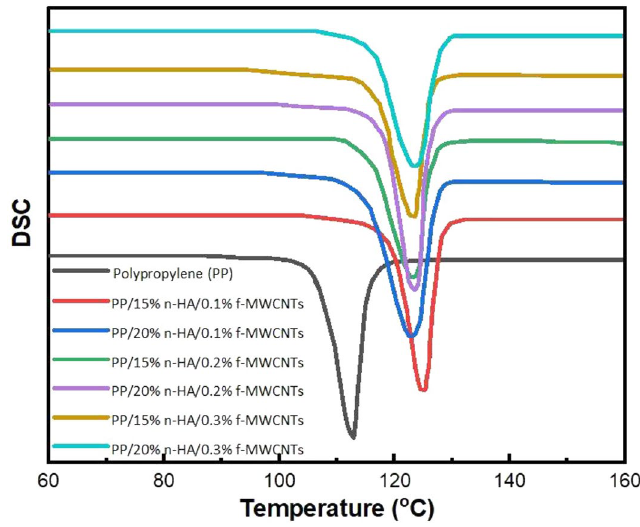
Figure 4. Differential scanning calorimetry curve of polypropylene and nanocomposites.